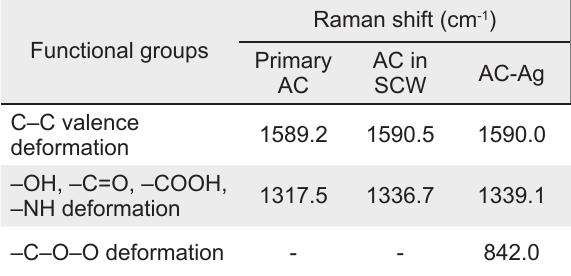
Table 3. Raman spectrum interpretation